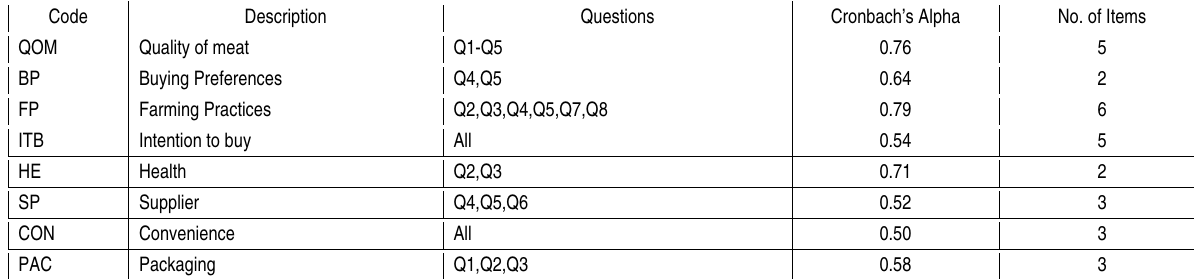
Table 4. Reliability of the